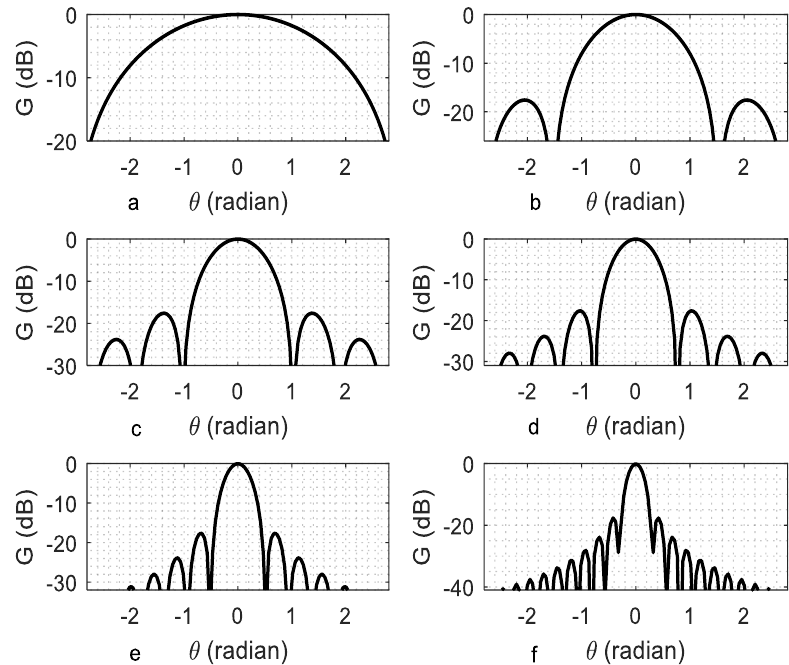
Fig. 4: Antenna gain (G (dB)) as a function of (elevation (θ)): a – Antenna diameter (D = 1 m), b – Antenna diameter (D = 2 m), c – Antenna diameter (D = 3 m), d – Antenna diameter (D = 4 m), e – Antenna diameter (D = 5 m), and f – Antenna